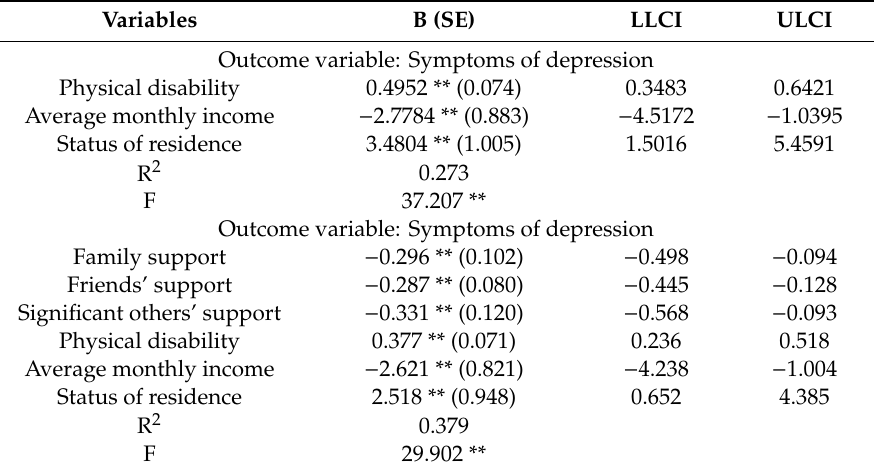
Table 4. Mediation e ff ect analysis based on PROCESS (Model